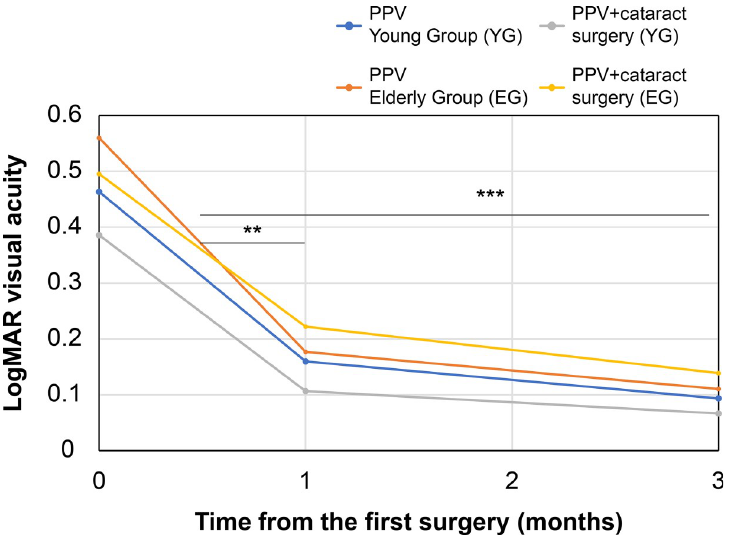
Fig 2. Changes in Best-Corrected Visual Acuity (BCVA) in patients with RRD with PVD.